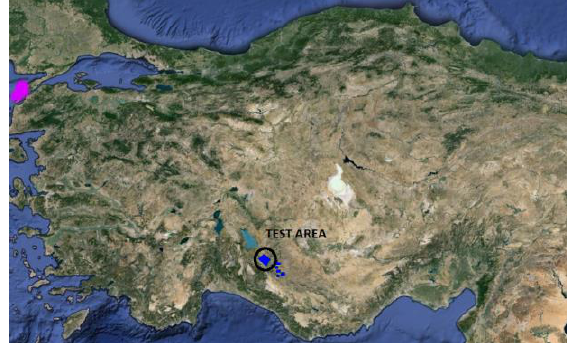
Fig. 1. The location of the test area Flights were conducted on the northwest-southeast